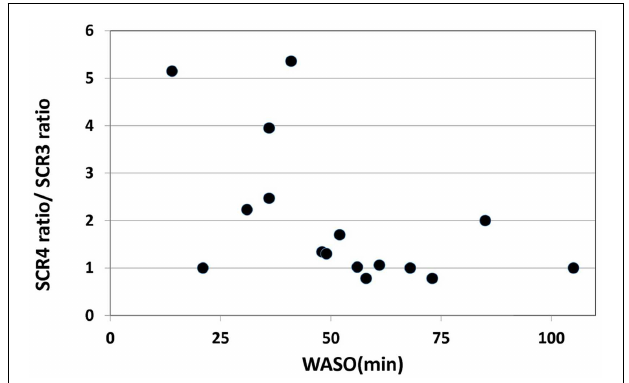
FIGURE 4 | Correlation between the change in the SCR ratio and the amount of nocturnal waking, as represented byWASO (wake after